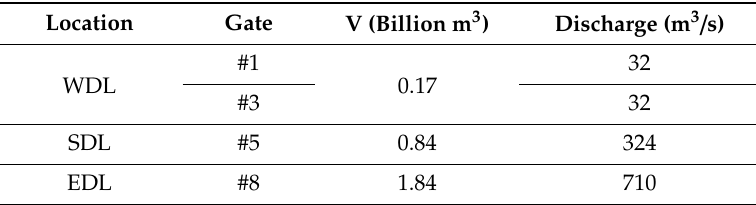
Table 2. The flow rate at each gate.